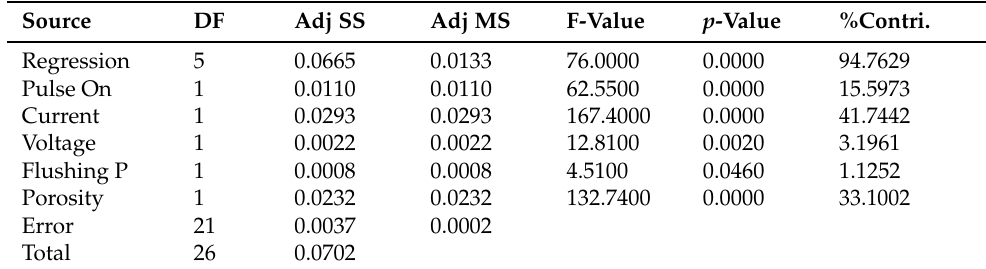
Table 5. Analysis of variance Analysis for MRR.